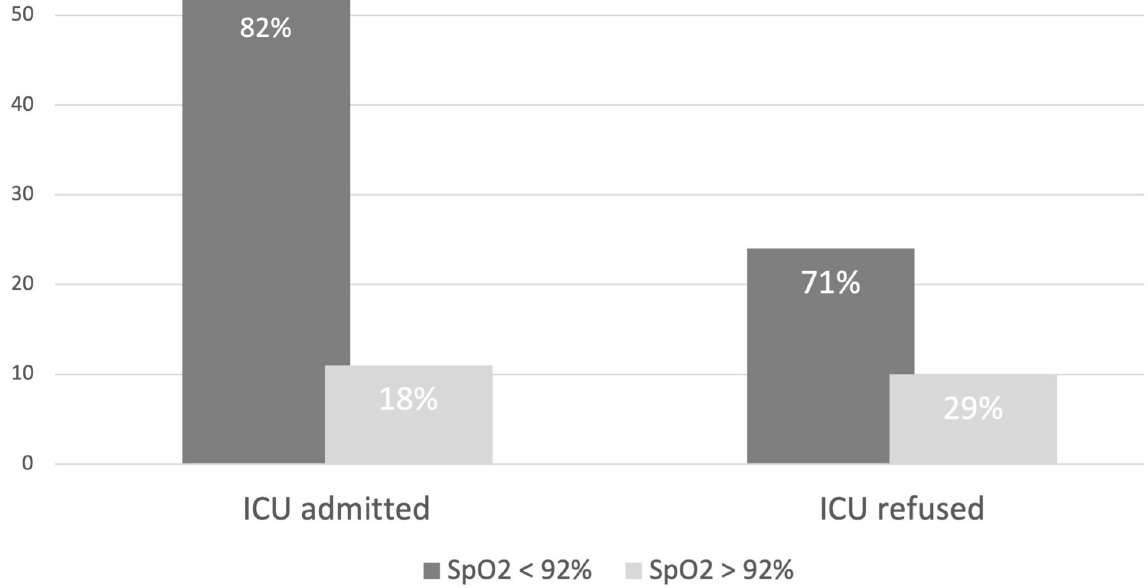
Fig 3. Patients SpO 2 distribution. Prevalence of SpO 2 distribution in patients at the Intensive Care consultation, stratified according to ICU admission ( ICU-admitted , ICU-refused ). In the ICU-admitted group, 52 of 63 patients (82%) presented a SpO 2 less than 92%; in the ICU-refused group, 24 of 34 patients (71%) presented a SpO 2 less than 92%. Chi-square analysis confirmed the identical distribution (p value = 0.26). Nearly a quarter of patients in the ICU-refused group presented a SpO 2 lower than 92%, without any ICU specific inclusion criteria, and their clinical conditions progressively